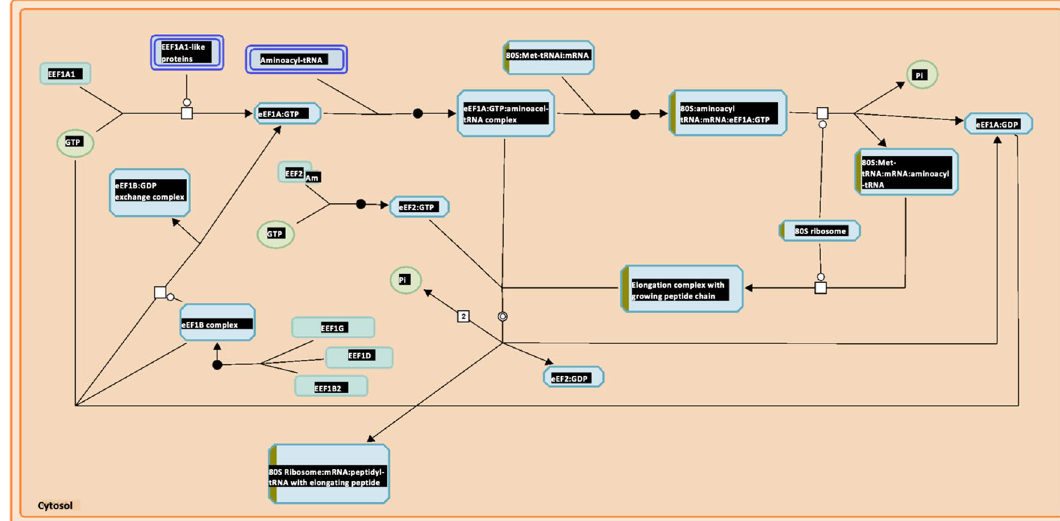
Figure 8. Peptide elongation pathway is downregulated in LUSC when compared to LUAD 28 . The peptide elongation pathway is the most down-regulated pathway according to Reactome analysis with p-value 9.72E−6 and FDR 0.00157. The boxes partially highlighted in brown indicate the number of genes identified in the analysis that are associated with each box.